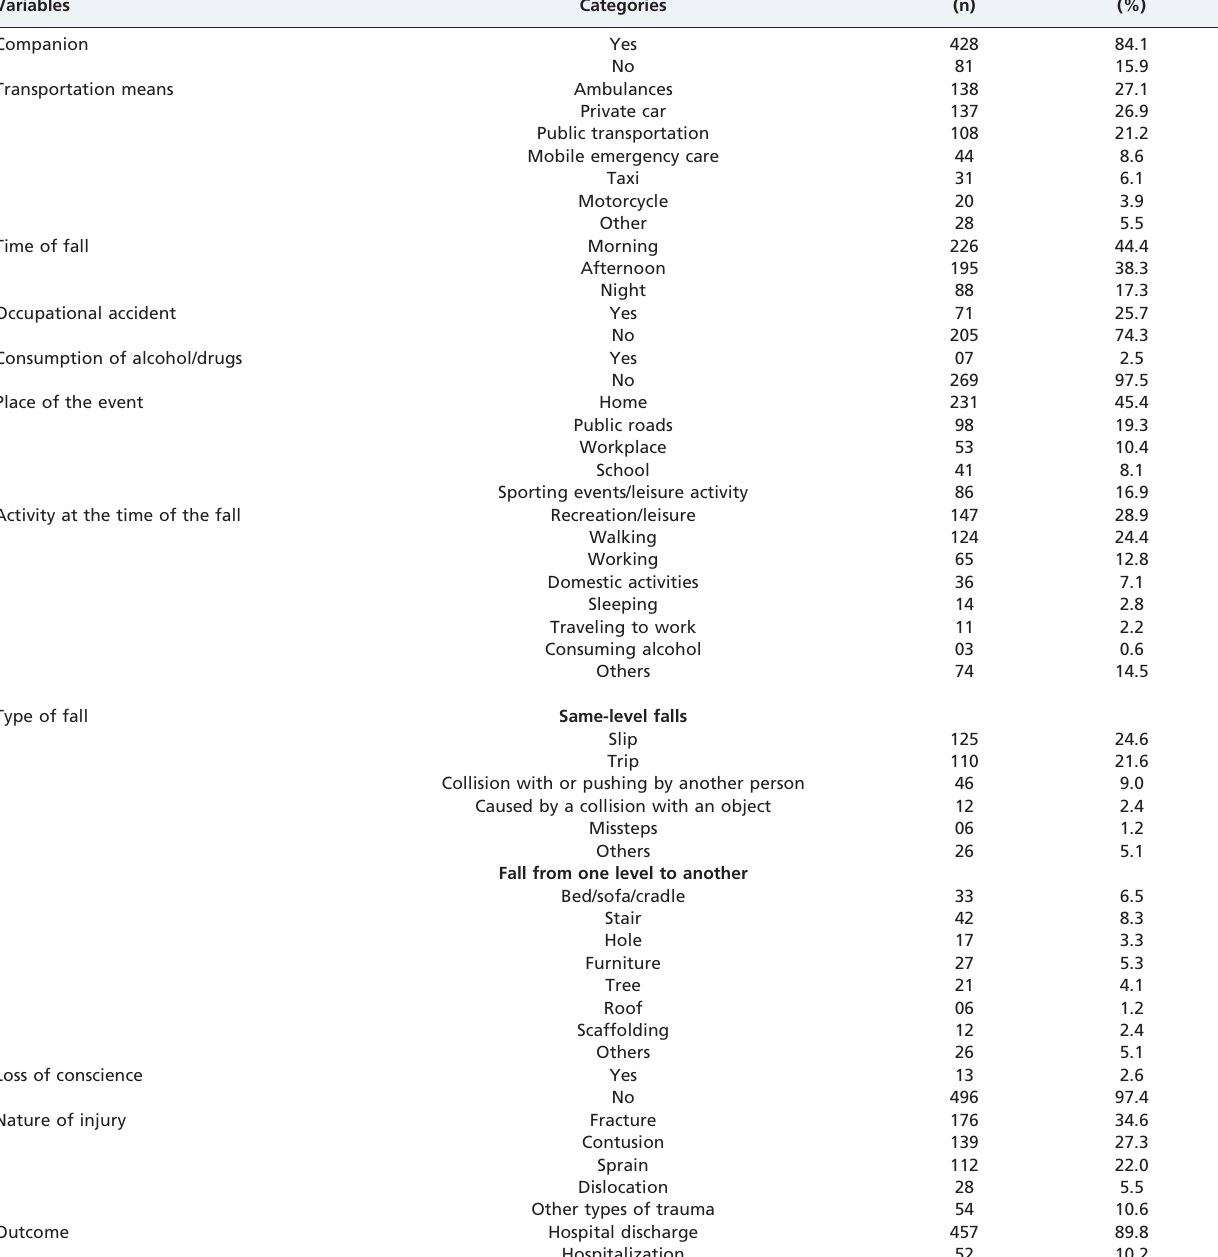
Table 2 - Characterization of fall-related traumas. Sergipe, Brazil, 2010.